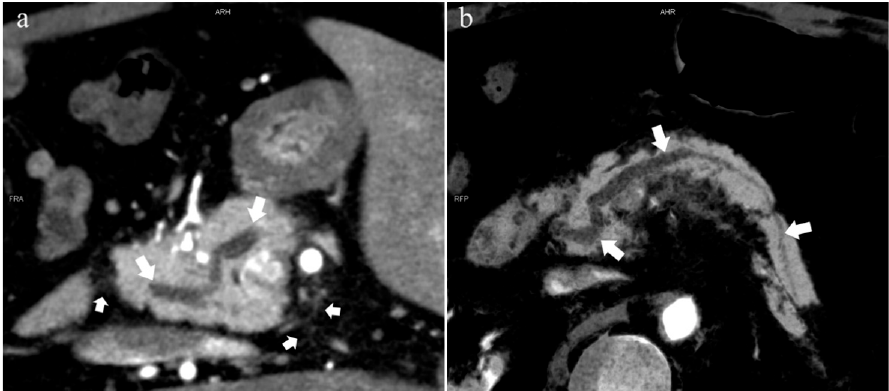
Figure 4. Type 3b, 63-year-old male patient with AP. ( a ): MIP [45 keV MEI (+)] shows an S-shaped dilated MPD (long arrow) in the head of the pancreas. APD is not displayed. The fat space around the head of the pancreas is blurred (short arrow). ( b ): MinIP [45 keV MEI (+)] clearly shows the overall shape of “S”-shaped MPD.